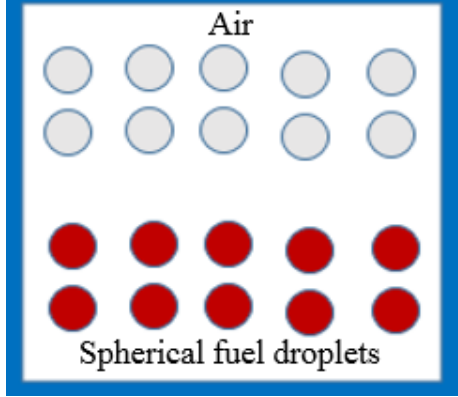
Figure 1. Schematic of air and spherical fuel